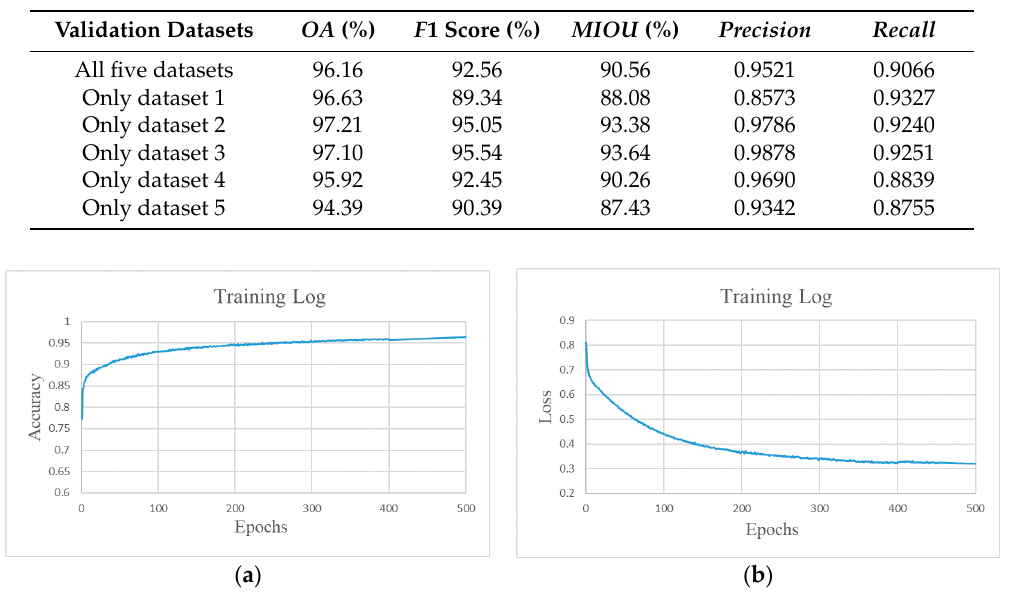
Figure 4 . Plots showing the accuracy and loss of the dense-attention network (DAN) for training the datasets. The training accuracy ( a ) and the loss ( b ) changed with the increasing epochs.